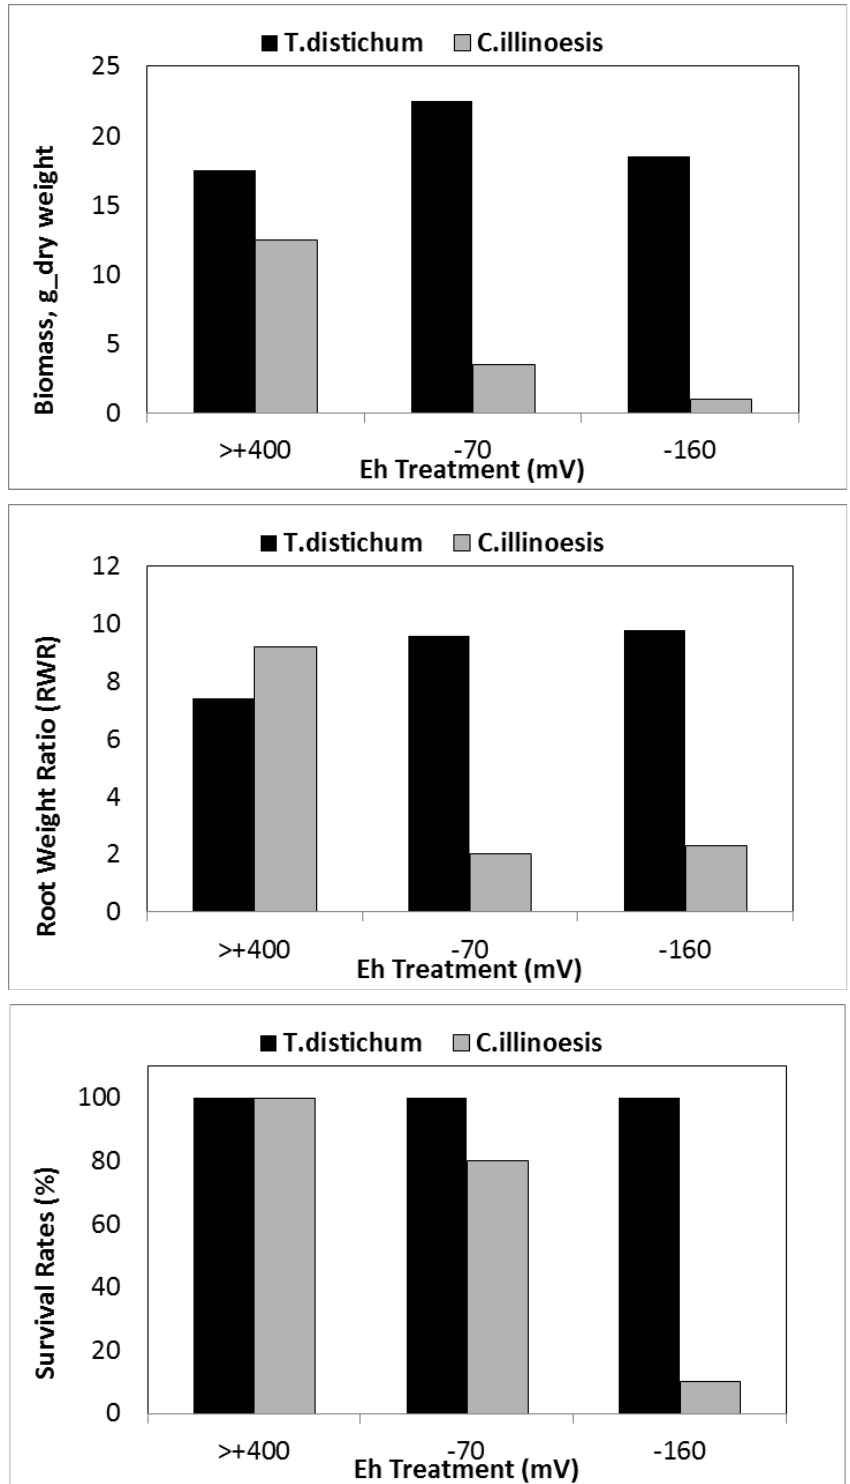
Figure 7. Biomass accumulation, root/weight ratio, and survival of two woody species Taxodium distichum and Carya illinoesis in response to changes in soil Eh conditions (from Pezeshki and Delaune